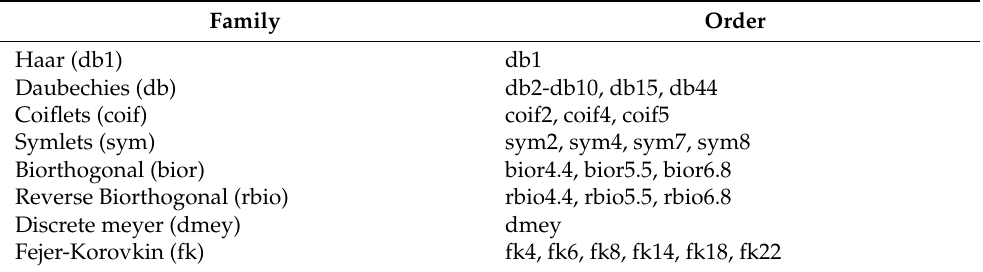
Table 5. Mother wavelet functions used in this study.